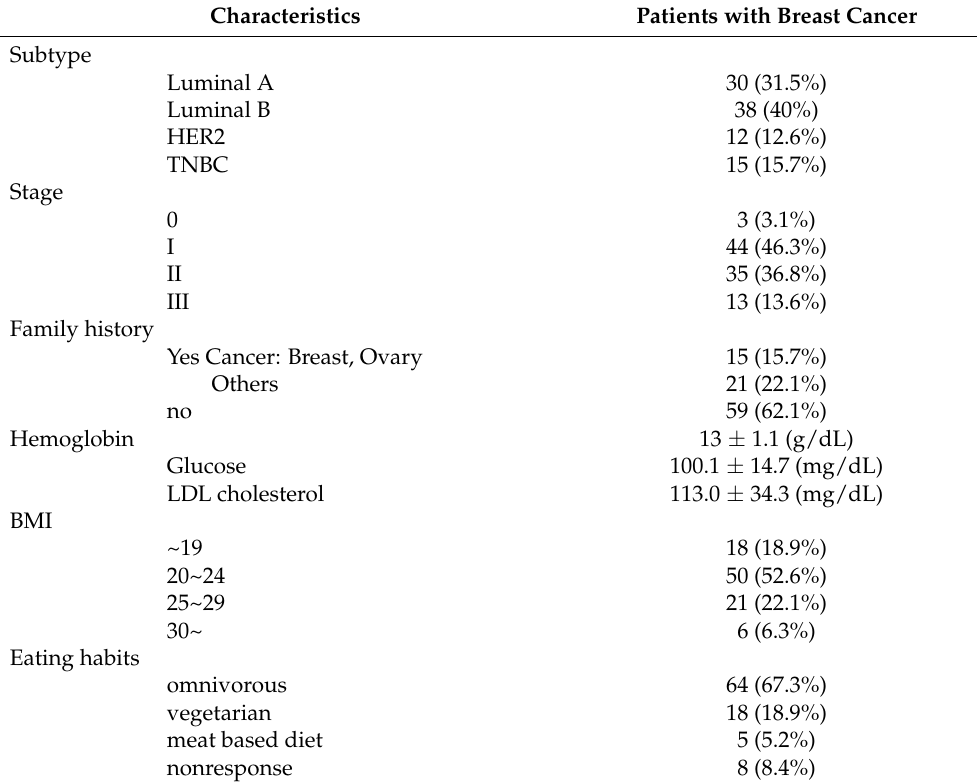
Table 2. Characteristics of patients with breast